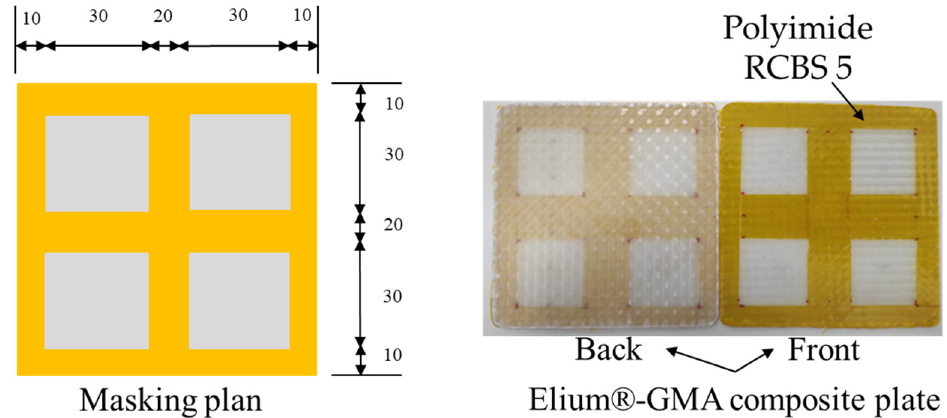
Figure 3. Masked Elium ® -GMA glass fiber composite (EMG) film preparation. All dimensions are in mm.